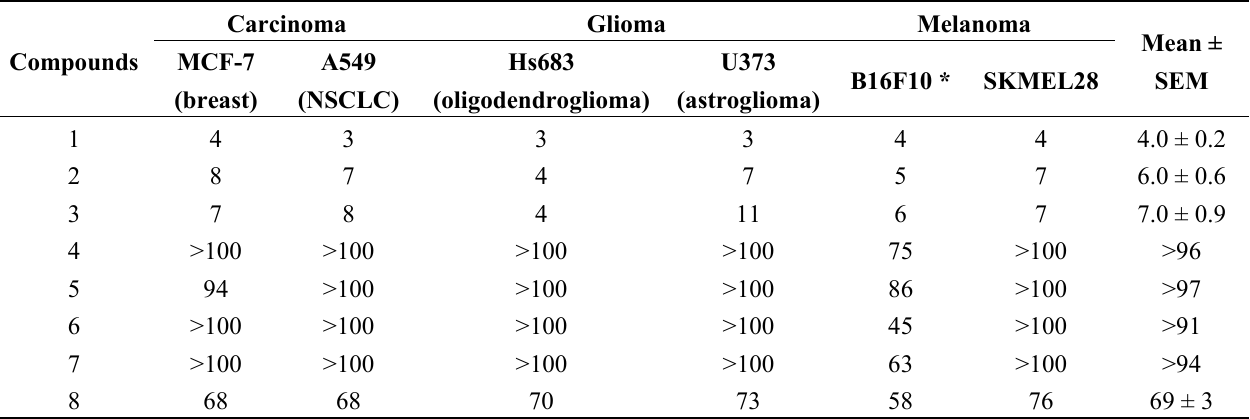
Table 1. In vitro growth inhibitory concentrations that reduce cell growth by 50% (IC µM) for compounds 1 – 8 (Figure 1) following culturing of the cancer cell lines with the compound of interest for 72 h (MTT colorimetric